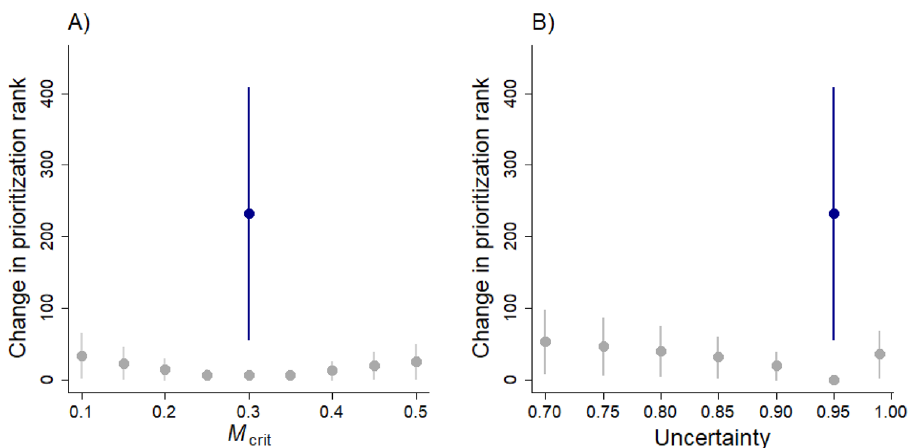
Figure 8. Shifting to a different conservation metric alters prioritization (represented in blue) more so than assuming a different M crit (in gray, A ) or acceptable uncertainty level ( α ) (in gray, B ). We show the mean change in priority rank, compared to using a metric of coho habitat, with M crit = 0.3 and α = 0.95. Blue dots show the mean change in priority rank when shifting from a metric of coho habitat to a metric of Chinook habitat (with M crit = 0.3 and α =